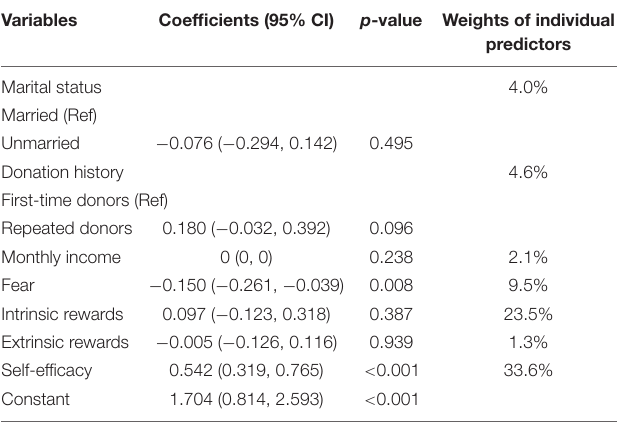
TABLE 4 | Multivariate regression models on the blood donation intention to